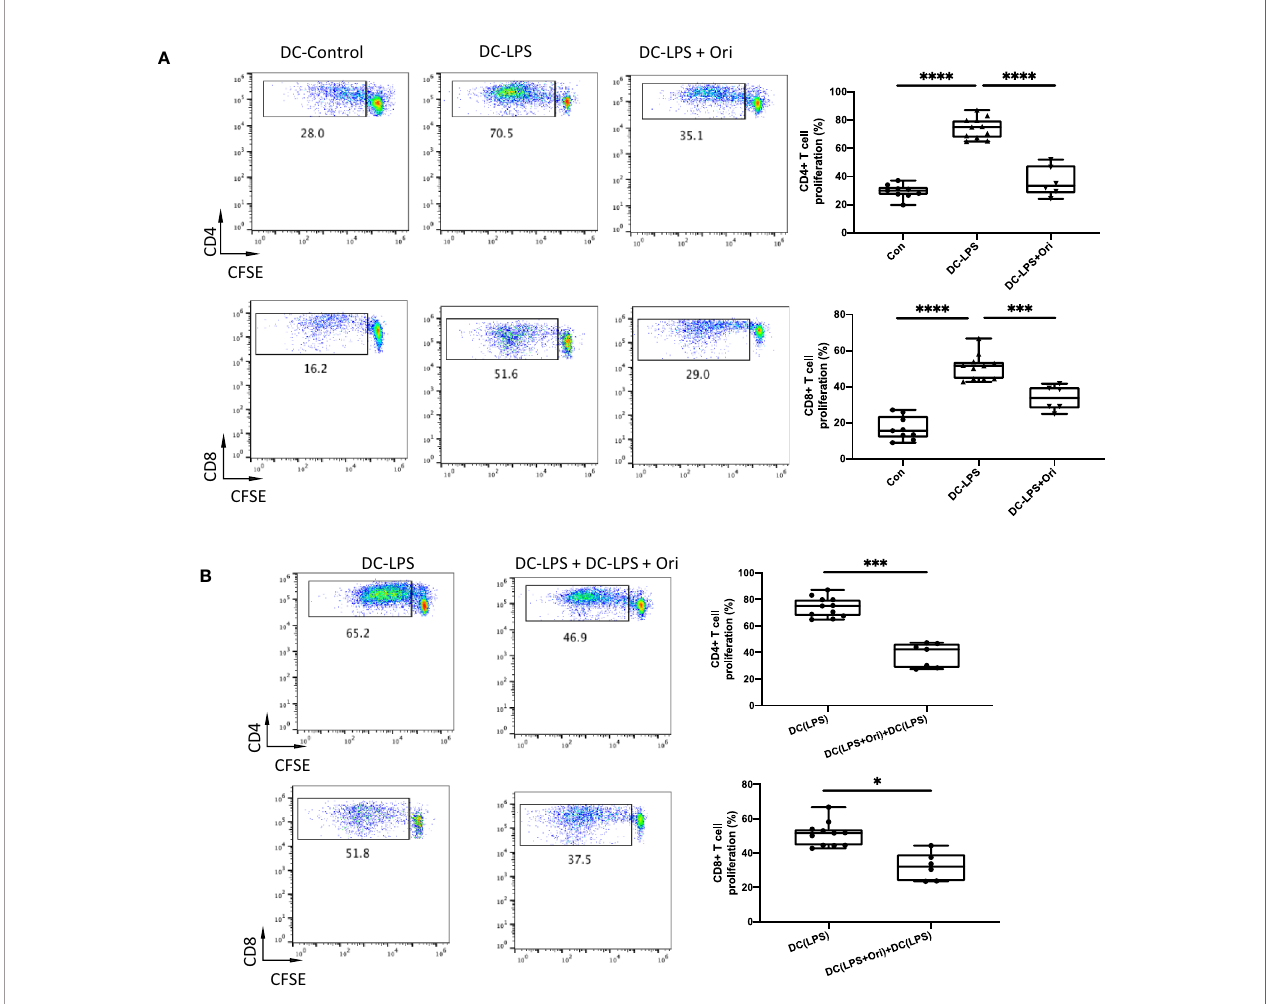
FIGURE 6 | Ori-treated BMDCs could suppress direct T cell proliferative responses in vitro . BMDCs were extracted from B6/N and then cultured with IL-4 (10 ng/ ml) and GM-CSF (10 ng/ml) in vitro . On day 5, different groups were treated with vehicle control; LPS 10 ng/ml (DC with LPS); and LPS (10 ng/ml) and Ori 3 m M (DC with LPS + Ori) for 48 h On day 7, the induced BMDCs (stimulator) were harvested and then irradiated with 20 Gy x-ray. T cells (responder) were isolated from the spleen of C3H, subjected to the Nylon column, and then stained with CFSE for one-way MLR. Coculture the three types of B6 DCs (DC-Vehicle, DC-LPS, and DC- LPS + Ori) with C3H-derived T cells in the ratio of 1:10 for 5 days. In another group, the Ori-treated BMDCs were added at the beginning into the culture as a regulator (regulator:stimulator = 1:1). Proliferation of T cells was stained with CD4 and CD8 and determined by FCM. (A) T cells from C3H were cocultured with three groups of BMDCs with the ratio 10:1 for 5 days. Proliferation of Teffs was determined by CFSE gated on CD4 + and CD8 + T-cell populations. Values are shown as the mean ± SD; * p < 0.05, ** p < 0.01. (B) T cells from C3H were cocultured with DC-LPS+DC-LPS + Ori (1:1) and DC-LPS with the ratio 10:1 for 5 days. Proliferation of Teffs was determined by CFSE gated on CD4 + and CD8 + population. Values are shown as the mean ± SD; * p < 0.05, ** p < 0.01, *** p < 0.001, **** p <